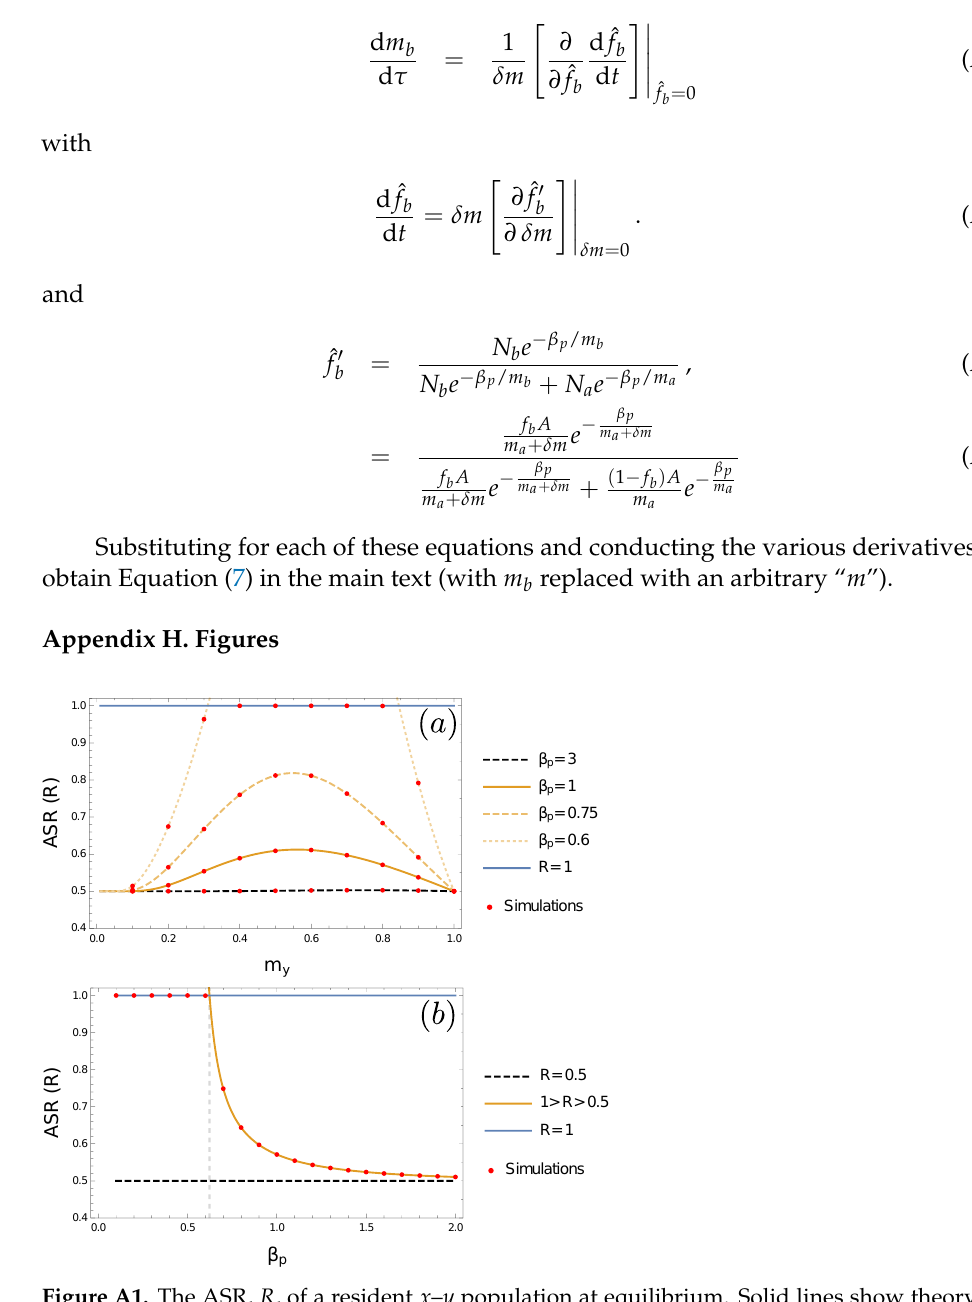
Figure A1. The ASR, R , of a resident x – y population at equilibrium. Solid lines show theory (see Equation (8)) while red markers give the results of simulations. Panel ( a ): β z = 1, m x = 1, (theory) and φ = 100, A = 1000, M = 1 (theory and simulations). Panel ( b ): Same parameters as panel ( a ), but with m y =